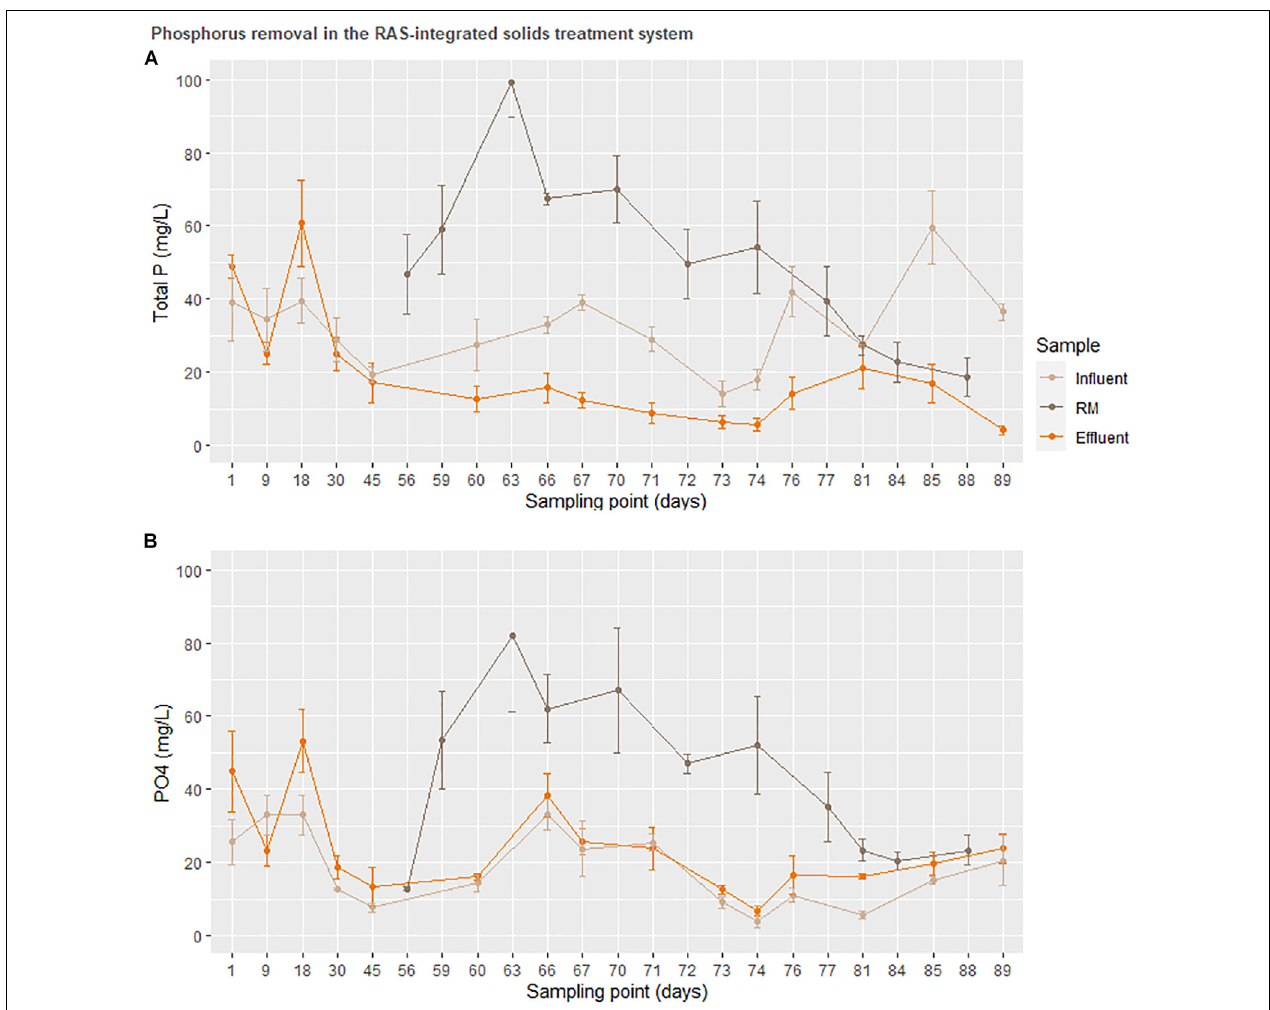
FIGURE 7 | Total (top) and soluble (bottom) phosphorus remineralization in the solids treatment system normalized to total mass transferred. The treatment RM was used to represent accumulation in a downstream hydroponic (HP)